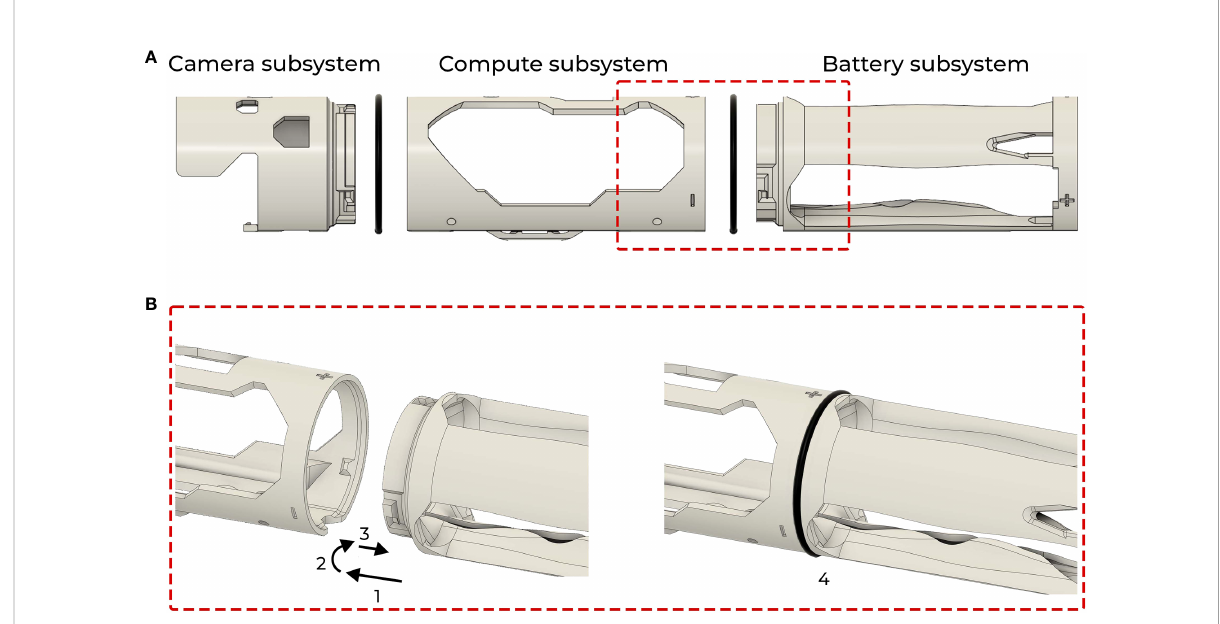
FIGURE 2 (A) The dry chassis consists of three modules with distinct functions. (B) Modules connect through a quick four step process: insert one module into another, twist, pull away, and fi nally place an O-ring in the gap. The O-ring prevents reversal of the described motion, while also functioning as a bumper between the chassis and the